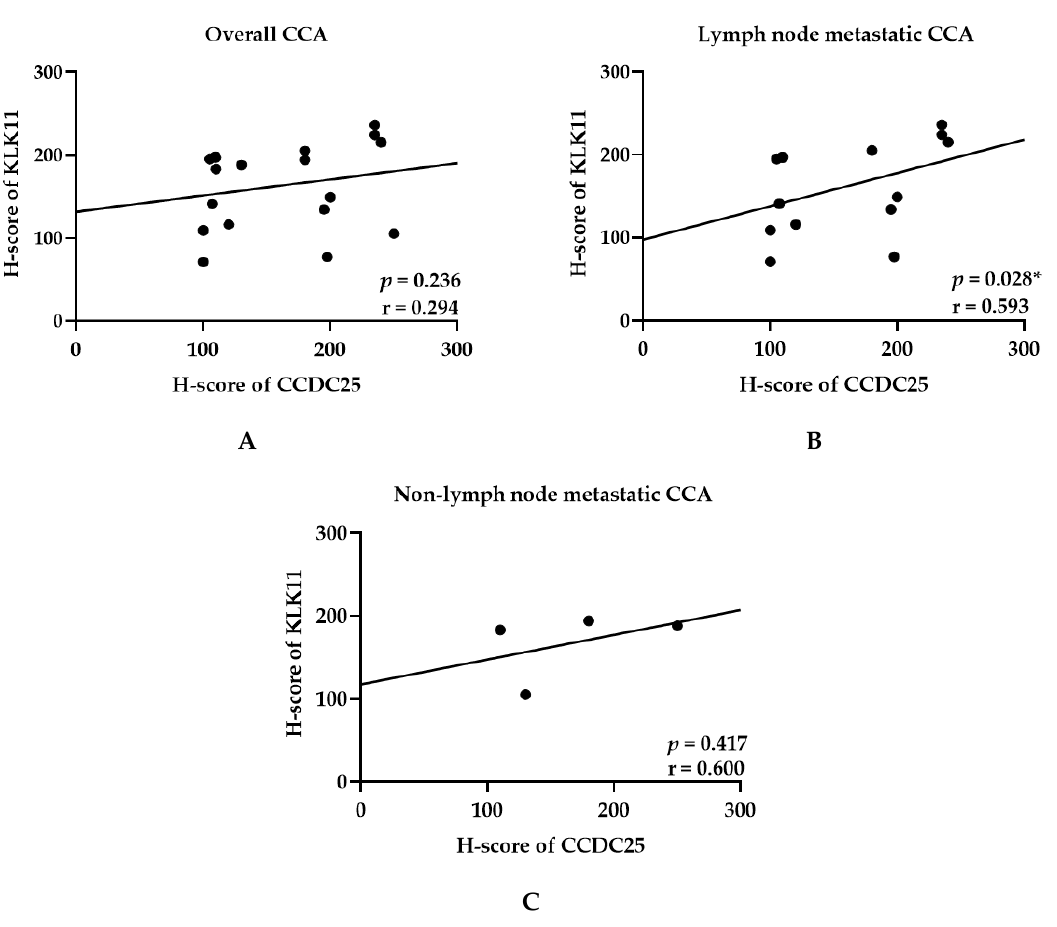
Figure 4. Correlation between CCDC25 and KLK11 H-score in cancerous tissues of ( A ) overall CCA patients, ( B ) CCA patients with lymph node metastasis, ( C ) CCA patients without lymph node metastasis. * Statistical significance ( p < 0.05).